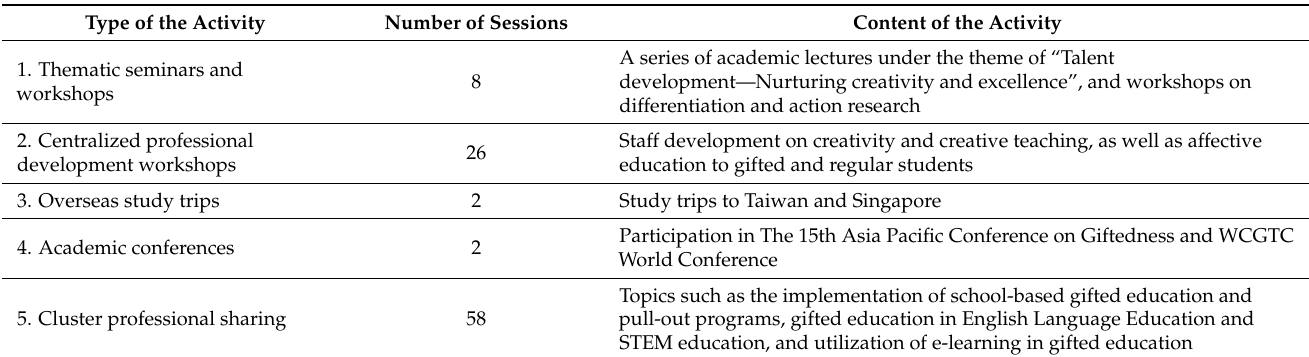
Table 1. Teacher training program of Project